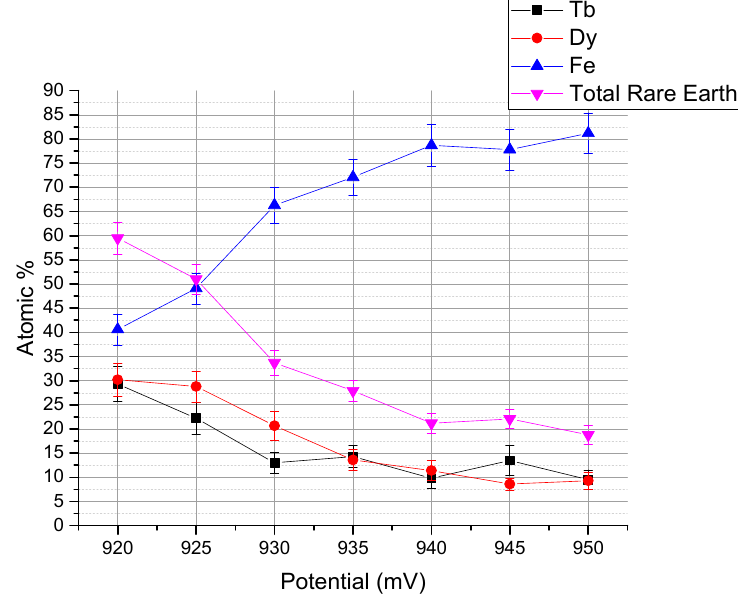
Figure 2. Composition dependence on the applied working electrode potential on a Cu seed layer.